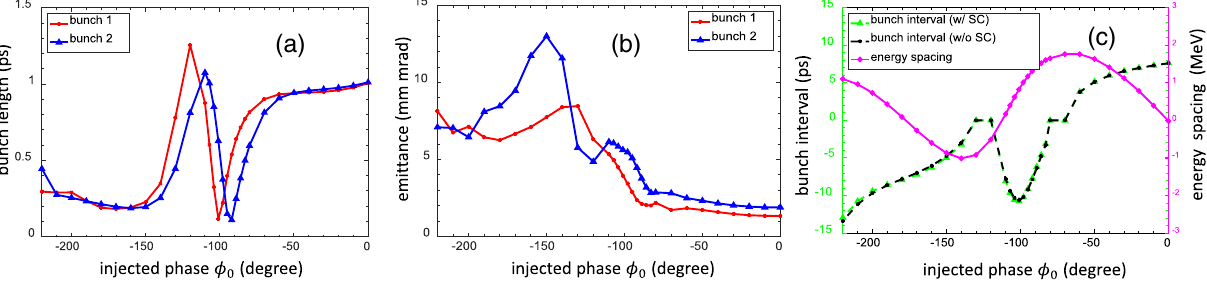
FIG. 8. Two-bunch compression results: (a) variation of the bunch length of each subbunch with ϕ 0 , (b) variation of the bunch emittance of each subbunch with ϕ 0 , and (c) variation of the bunch interval (with and without a space charge effect) and the energy spacing with ϕ 0